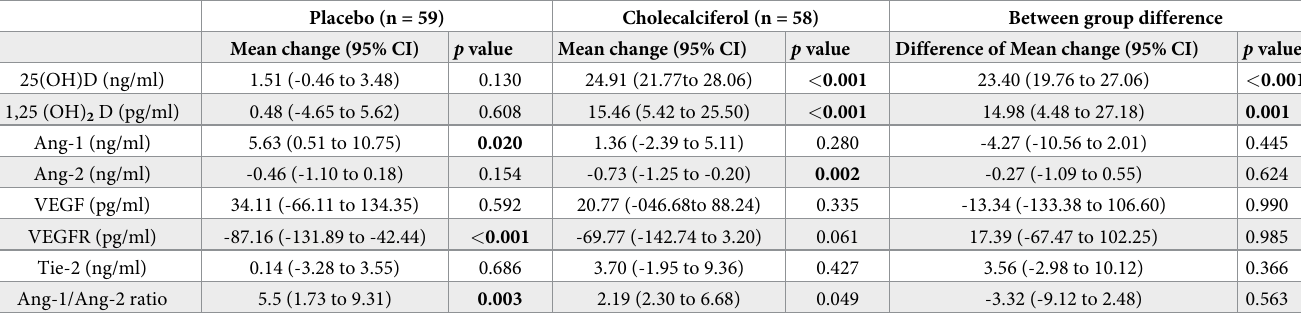
Table 3. Change in serum levels of vitamin D and angiogenic marker at 16 weeks follow-up. Placebo (n =